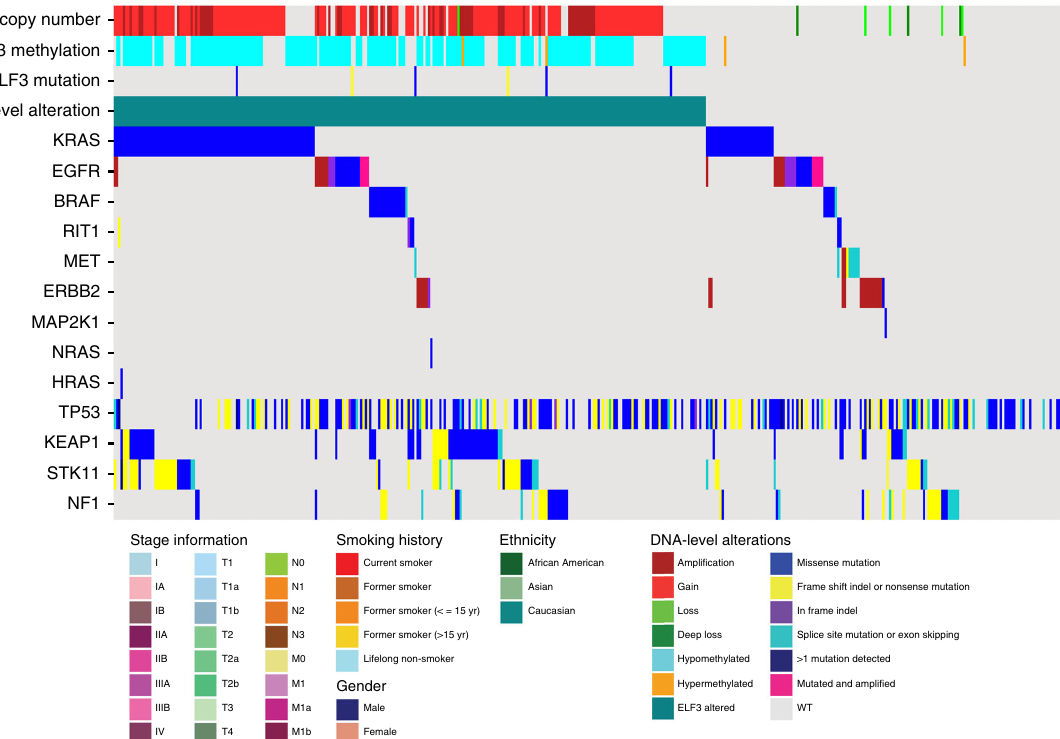
Fig. 3 High ELF3 expression is not dependent on the molecular subtype of lung adenocarcinoma. a Comparison of log 2 ELF3 expression and ELF3 immunohistochemistry (IHC) score between cases with or without driver mutations in EGFR and KRAS (BCCA n = 83, TCGA n = 484, Tissue Microarray n = 161, Mann – Whitney U test). In all box and whisker plots, center line represents the median, box bounds indicate the 25th and 75th percentiles, and whiskers extend from minimum to maximum. b Case-by-case representation of clinical features (upper panel) and genomic alterations (lower panel) across 420 LUAD from the TCGA data set dichotomized into those with and without DNA-level alterations at the ELF3 locus. Mutations and ampli fi cations in prominent oncogenes and mutations in tumor suppressor genes are